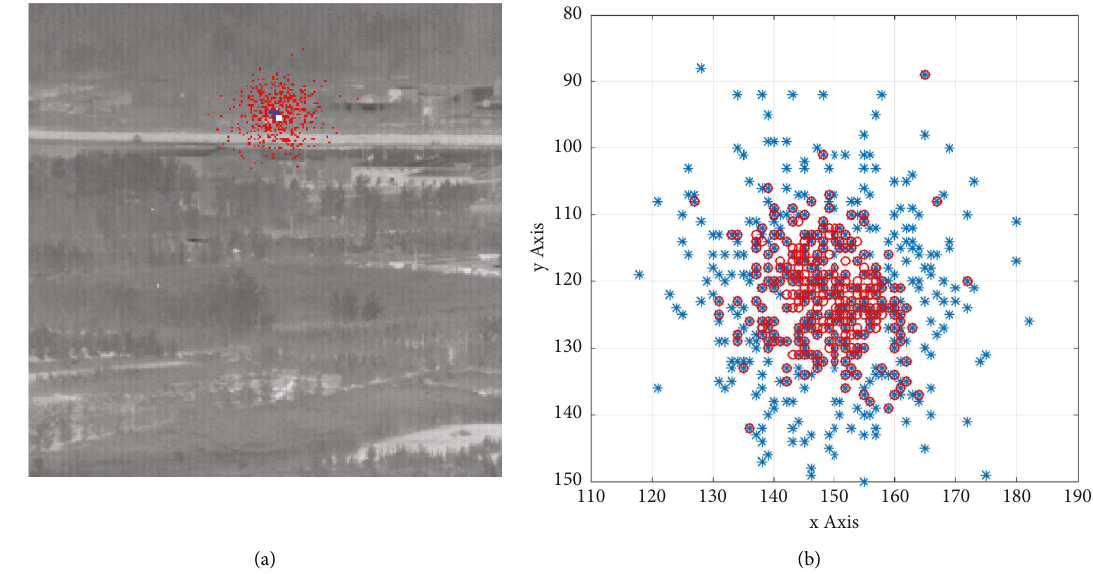
Figure 4: Dim-small object detection. (a) Distant target detection. (b) Particle distributions before and after resampling.